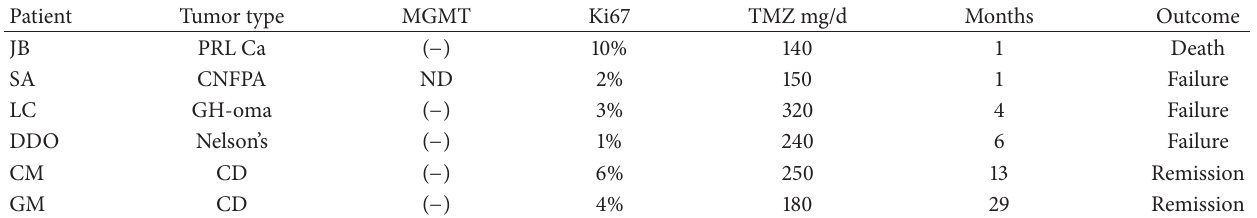
Table 2: Results of MGMT and Ki67 immunohistochemistry, doses, length of therapy, and clinical outcome in 6 patients with intention-to- treat with